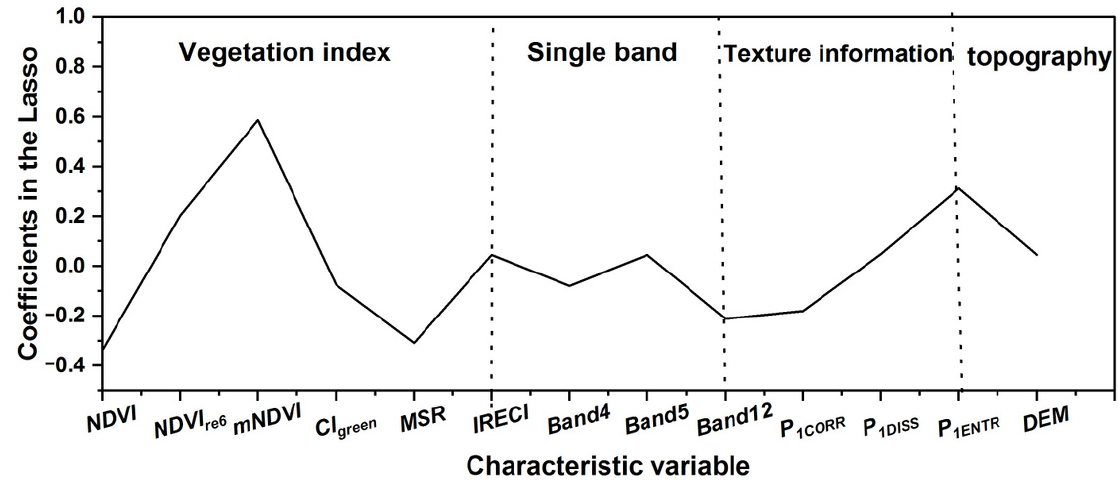
Figure 6. Lasso feature selection results.